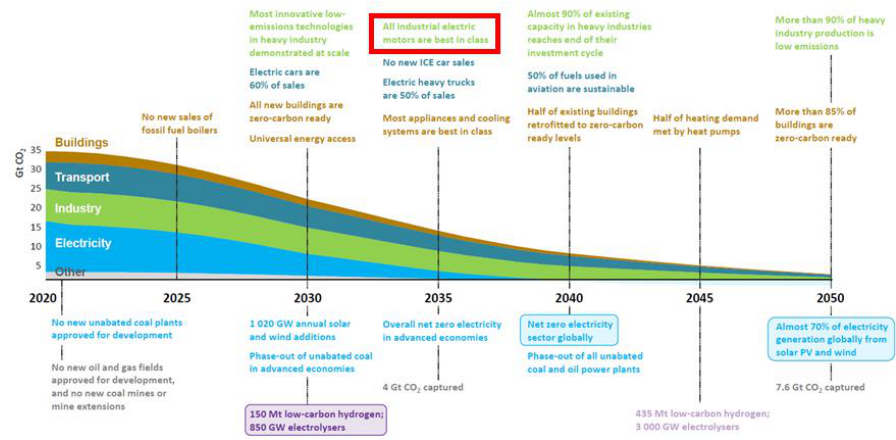
Figure 2. IEA Net Zero by 2050: A Roadmap for the Global Energy Sector .